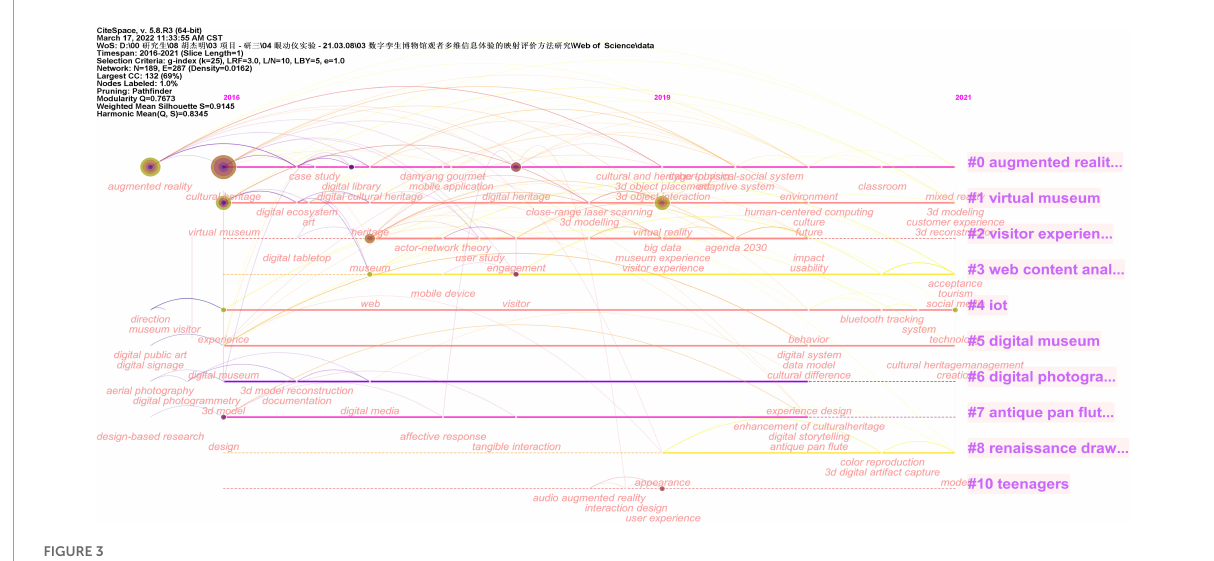
FIGURE3 Keyword cluster visualization graph. Image source: The information was retrieved by our research team and exported after CiteSpace analysis. Data source: The authors were retrieved through Web of Science.